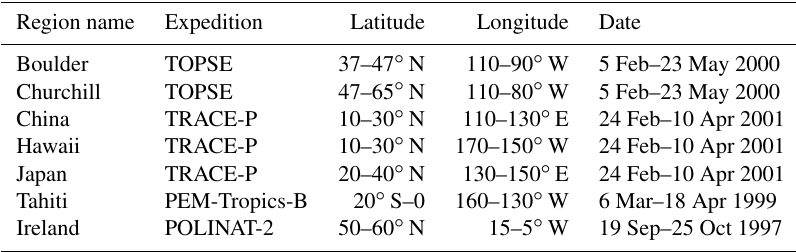
Table 5. Description of additional aircraft campaign data, including location and